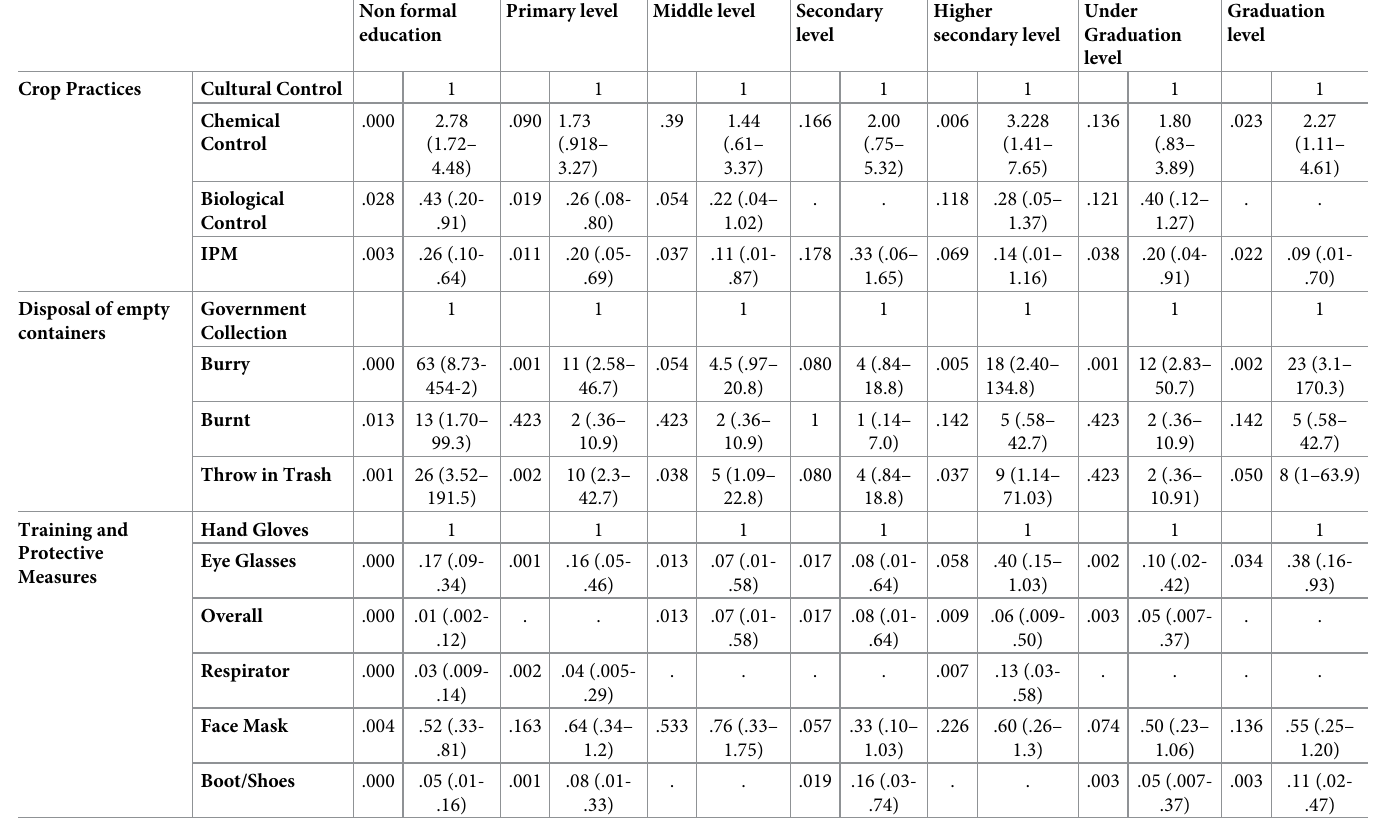
Table 5. Summary of regression analysis column of the table refers to the education level of the farmers and rows refer the practices of